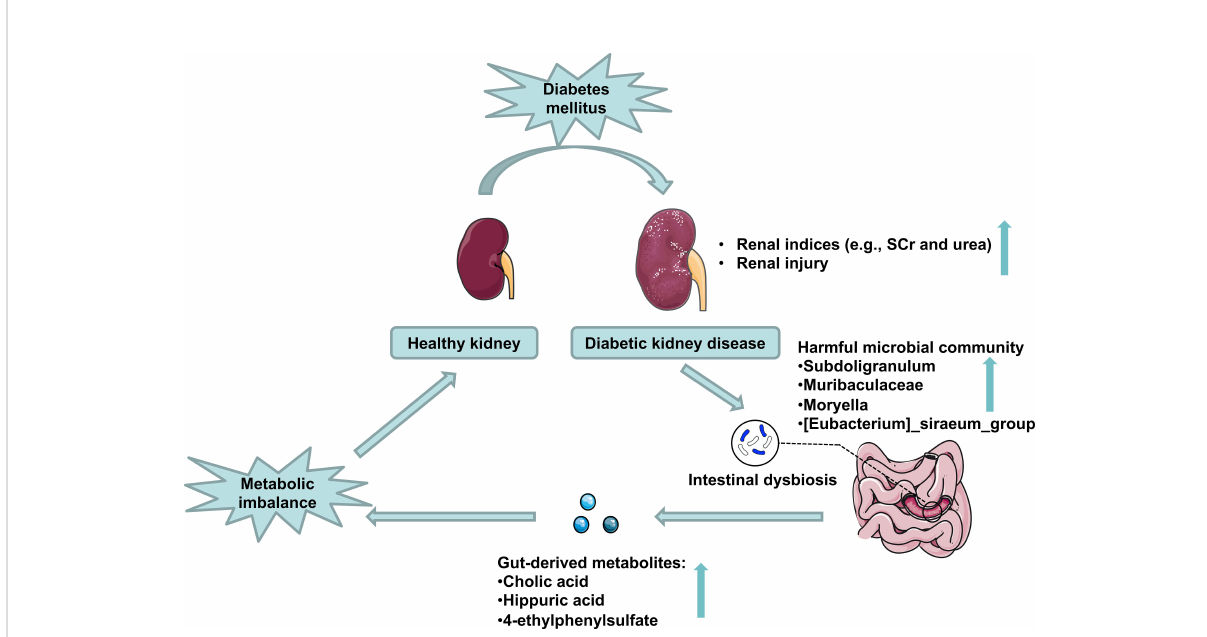
FIGURE 9 Schematic representation of the potential mechanisms of gut microbiota on DKD exacerbation. DKD induces intestinal dysbiosis, which presents as harmful microbial community accumulation, further increasing gut-derived injurious metabolites production, which disturbs host serum metabolomics and exacerbates DKD